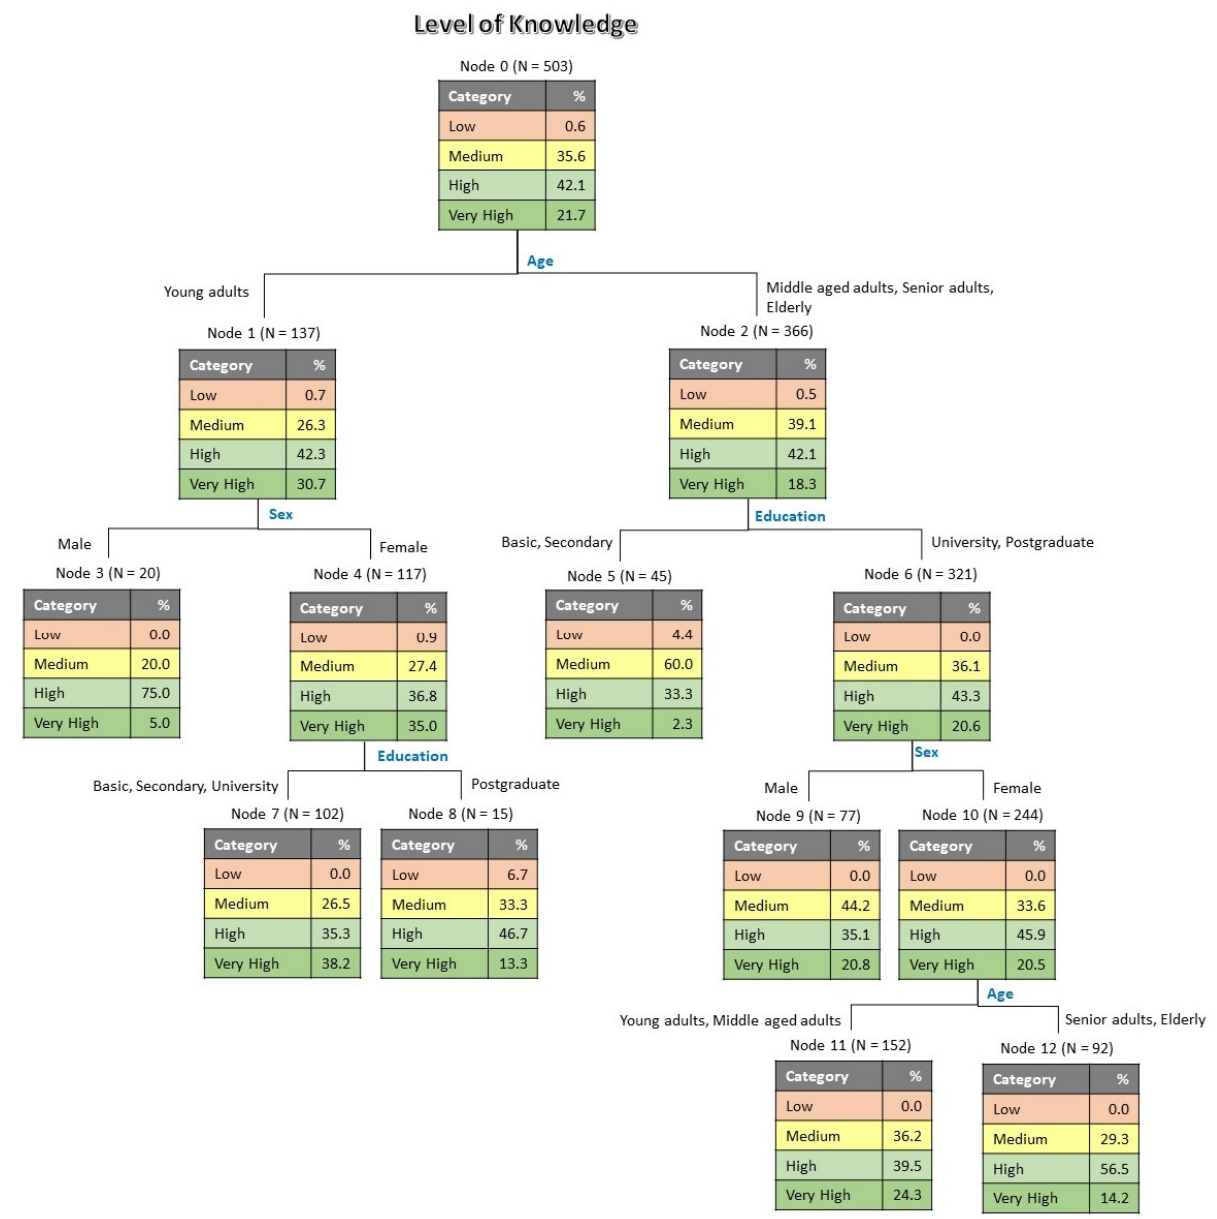
Figure 1. Tree classification for level of knowledge as influenced by sociodemographic variables.